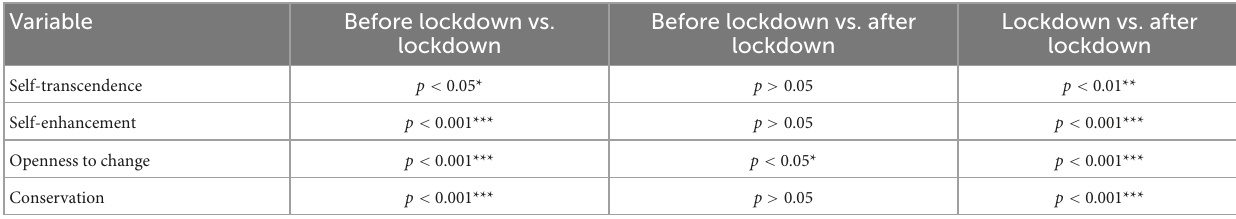
TABLE 5 The differences in correlations between circumstances before the lockdown, during the lockdown, and after the lockdown and individual level higher-order dimensions of personal values.